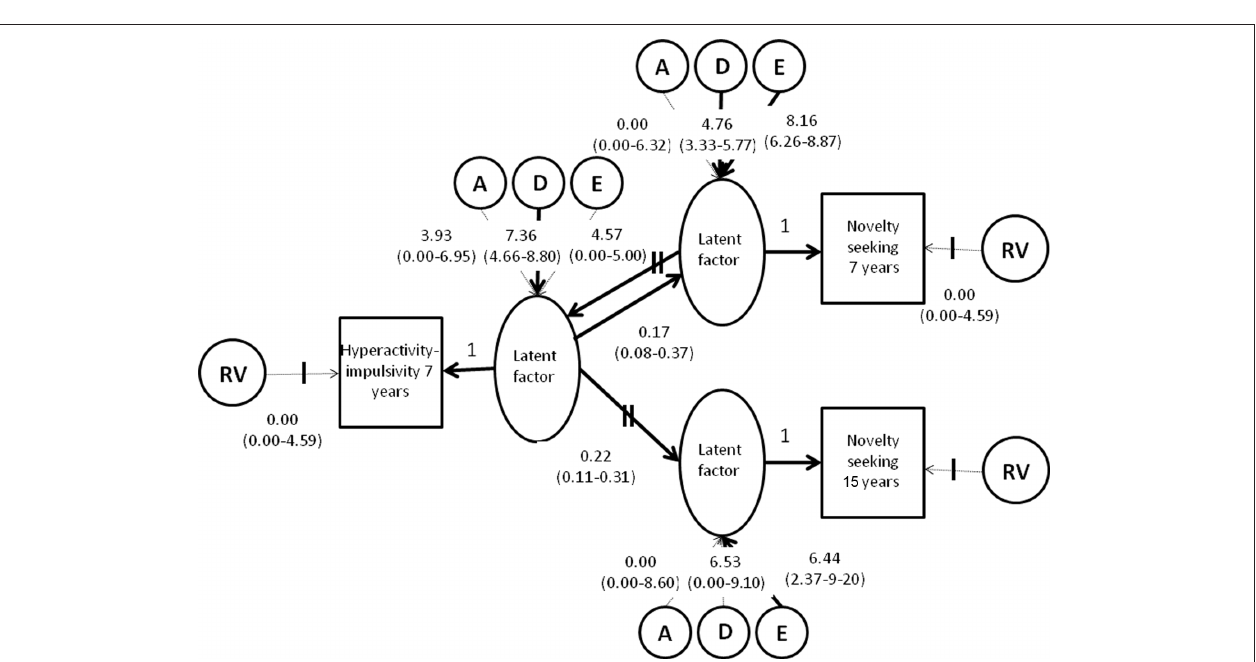
FiGure 1 | Correlated factors solution of the Cholesky model ( + 95% confidence intervals; significant paths in bold). Note: Measured variables are represented by squares and described in the Section “Materials and Methods.” Latent (unmeasured) variables are represented by circles according to tradition (McArdle, 1980).